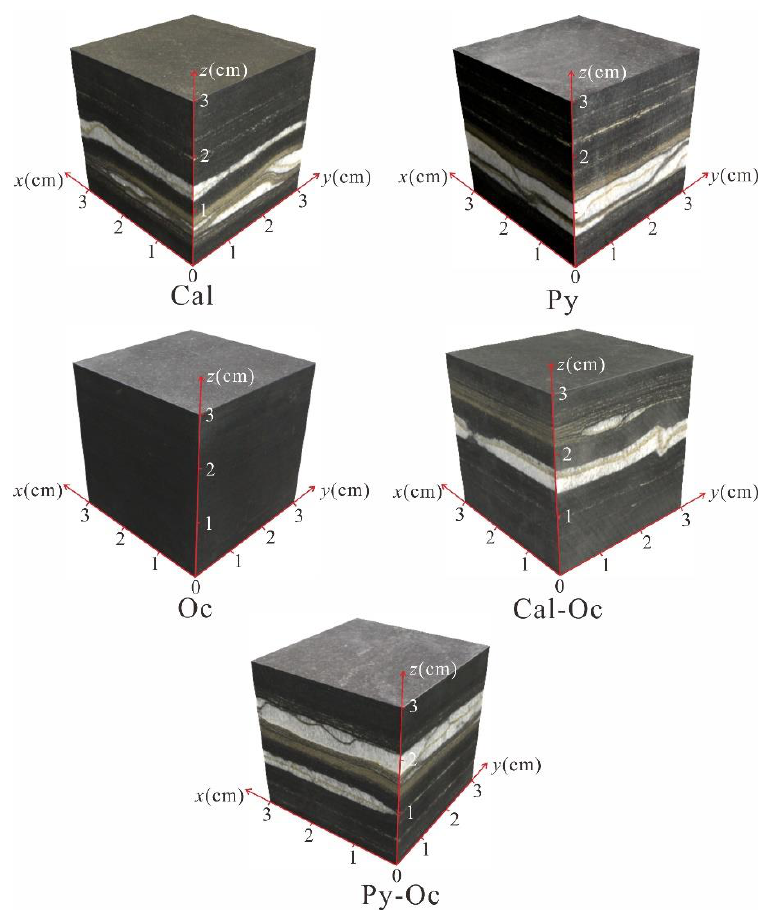
Figure 3. Cubic specimens prepared with various central laminae.